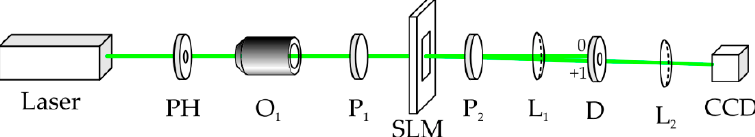
Figure 5. The experimental setup: Laser is MGL-F-532-700mW ( λ = 532 nm, 700 mW); PH is pinhole (d = 200 μ m); O 1 is 100 × objective lens; P 1 , P 2 are linear polarizers; SLM is spatial light modulator (Holoeye LC 2012); L 1 , L 2 are lenses (with the focal lengths of f 1 = 100 mm and f 2 = 50 mm); D is diaphragm to block the zero diffraction order; CCD is CCD camera (UCMOS 10000KPA).